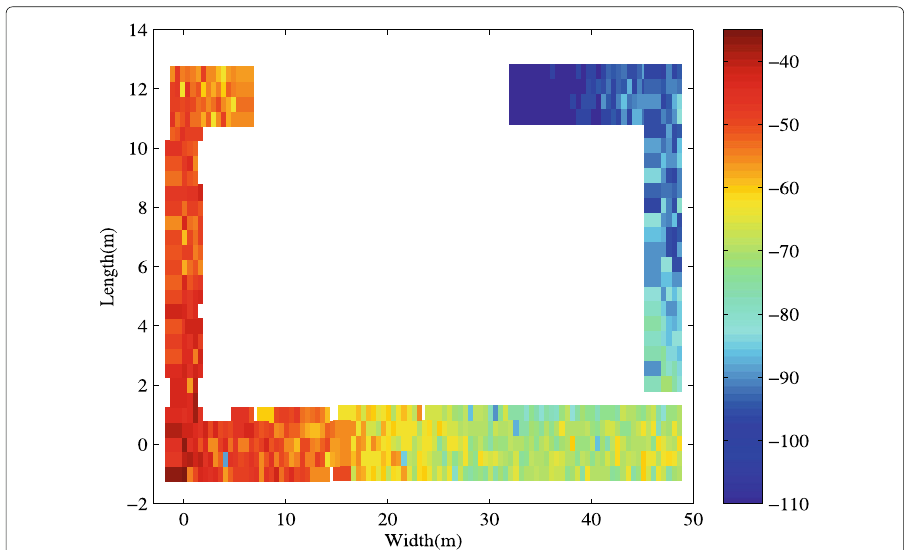
Fig. 13 Signal distribution of radio map built by step-counter-assisted